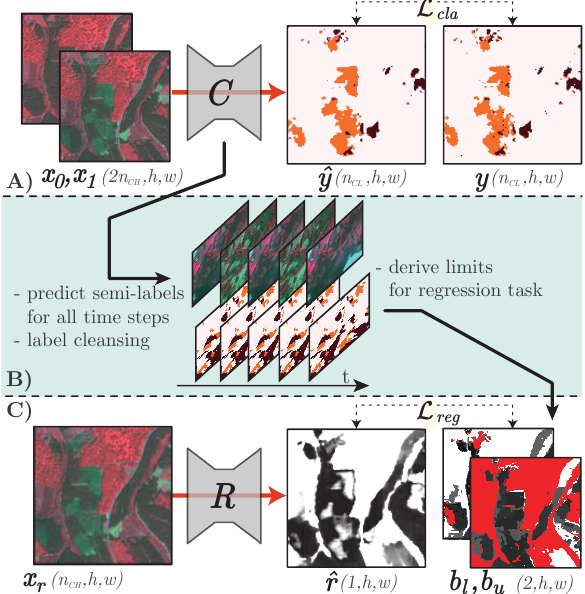
Figure 1. Method overview. A) A CNN C is trained to predict forest damage from an image pair [ x 0 , x 1 ], using reference labels y . B) C is used to predict semi-labels for a time series of unlabelled images; they are used to derive the interval limits b l , b u for the regression task. C) A CNN R is trained to predict the RLT ( ˆ r ) for each pixel in an input image x r . Colour codes for ˆ y and y : orange - death of trees, brown - clear-cuts, white - background. Colour-codes for ˆ r , b l and b u : grey-values - RLT (darker . . . shorter time), red - interval limit